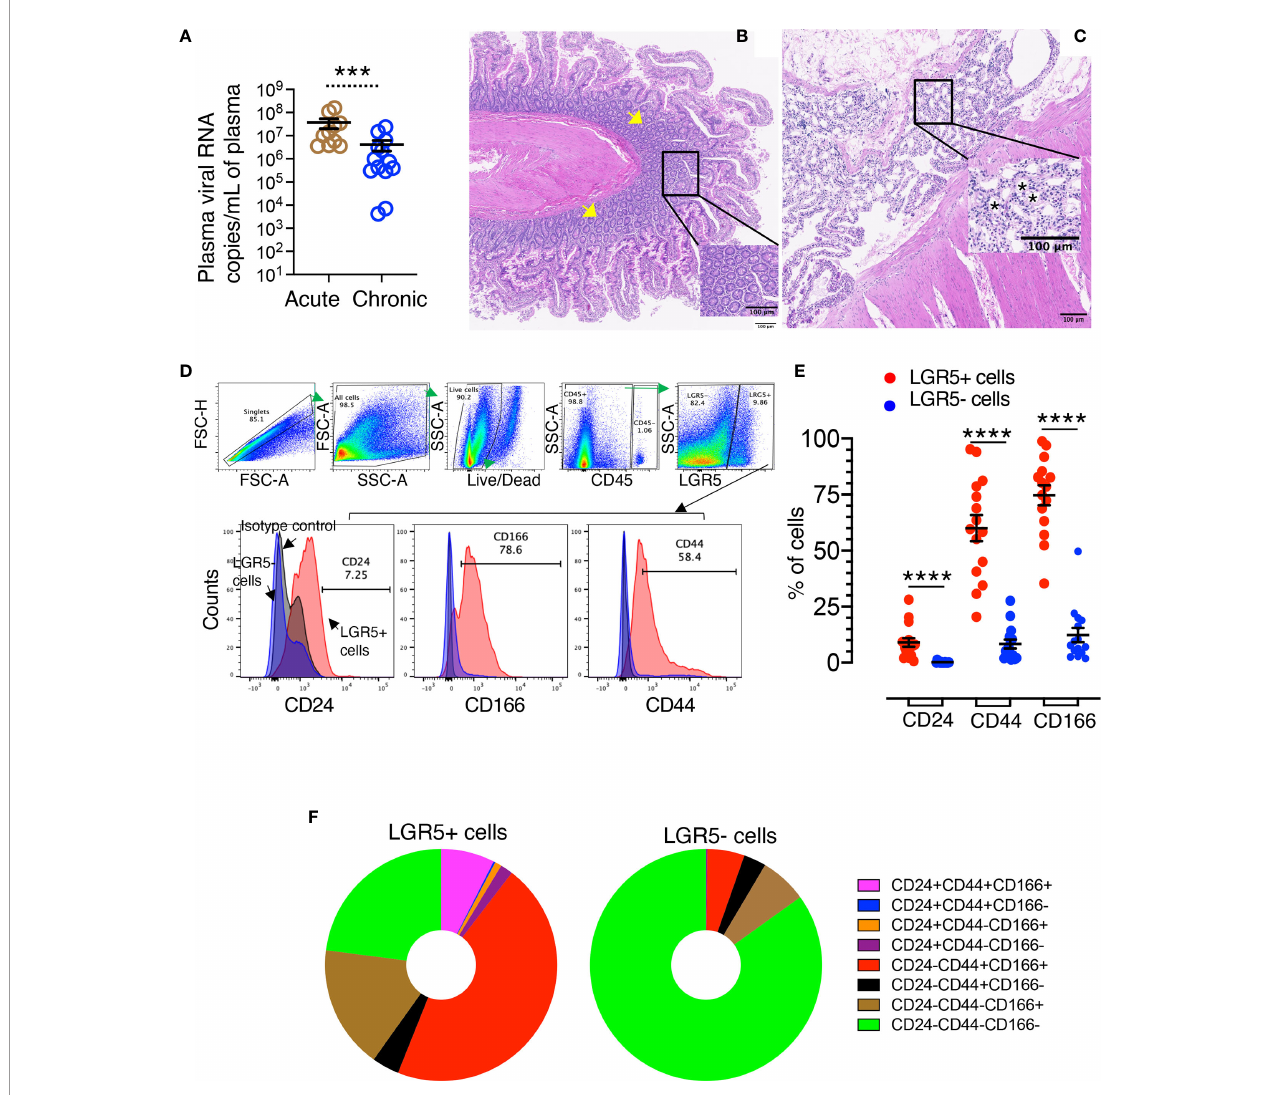
FIGURE 1 | Isolation of jejunum crypts and phenotypic characterization of LGR5+ intestinal stem cells. (A) Plasma viral loads with mean (± standard errors) in macaques during acute (n=10) and chronic (n=13) phases of SIV MAC 251 infection. Statistically signi fi cant differences between groups as analyzed with Mann- Whitney t-test are indicated with asterisks (*** p = 0.001). (B) Jejunum crypts were isolated using a low temperature isolation method as discussed in the Materials and Methods section. Pre-processing normal jejunum tissue where the tissue architecture with abundant crypts and villi lined by enterocytes (yellow arrows) are maintained (JT62). Inset: Higher magni fi cation of normal crypts. (C) Post processing jejunum tissue with a complete absence of enterocytes and a loss of crypts (JT62). Inset: Higher magni fi cation showing empty spaces where crypts are missing (asterisks). (D) A representative gating strategy of LGR5+ cells from a normal healthy uninfected rhesus macaque is shown. Crypts were further enzymatically digested and single-cell suspension was further stained for different cell phenotypic markers. Cells were gated fi rst on singlets, all cells, followed by live cells, and then gated on CD45- cells. All CD45- cells were further gated for LGR5+ and LGR5- cells. Both LGR5+ and LGR5- cells were further gated on different cell surface markers like CD24, CD44, and CD166. The percentages of either CD24, CD44 or CD166 for LGR5+ cells (in red color) are shown in the left bottom row, where the positive responses for those surface markers were compared to the isotype (grey color) and LGR5- cells (blue color) using histograms. (E) Nine SIV-uninfected normal RMs, of which six were run in duplicate, were examined for their LGR5 expression. Frequency of CD24, CD44, and CD166 surface markers were compared between LGR5+ and LGR5- cells. The horizontal line denotes the mean frequencies (± standard errors) of each category. Statistically signi fi cant differences between cells as analyzed with Mann- Whitney T-test are indicated with asterisks (**** p < 0.0001). (F) LGR5+ and LGR5- cells were further analyzed based on their CD24, CD44, and CD166 surface expression. The majority of the LGR5+ cells were found to be positive for CD44 and CD166 surface molecule expression, whereas about 85% of LGR5- cells were found negative for CD24, CD44, and CD166 markers. One-way ANOVA with Tukey ’ s multiple comparison test was performed to calculate signi fi cant differences among different cell subsets. A p -value < 0.05 was considered signi fi